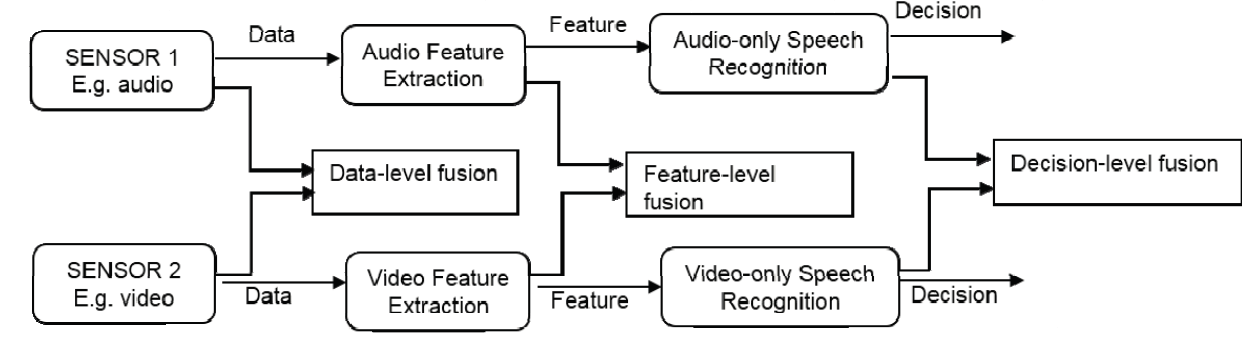
Figure 10. Levels of multimodal fusion (adapted from